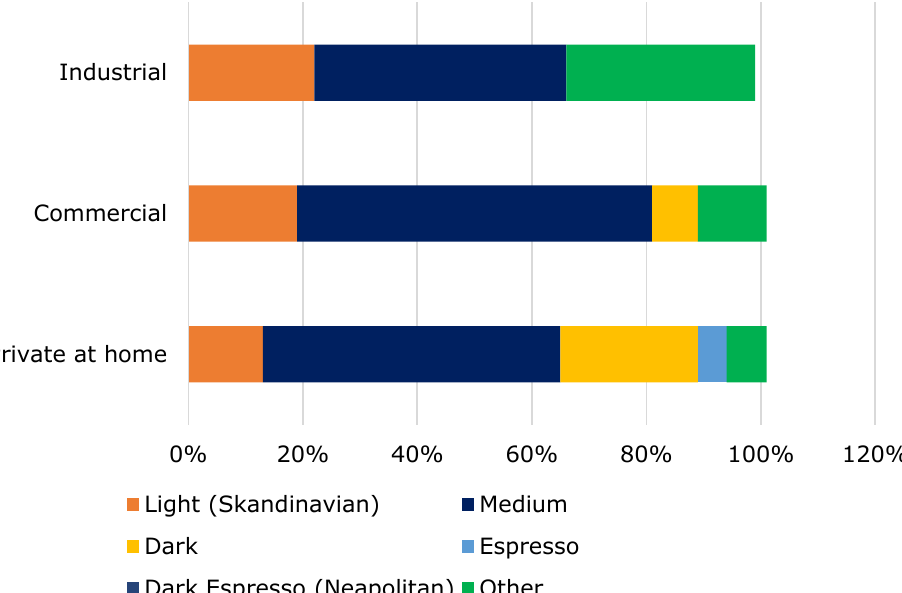
Figure 4. Grinding degree of cold brew coffee. Most of the respondents (53%) use Arabica beans for making cold brew coffee. Only a few (1.7%) use Canephora, Liberica or a blend of several species (3%). However, there are also some participants (41%) who do not know what kind of variety they use. respondents. Nineteen percent use a dark and 15% a light roast. An espresso roast is used